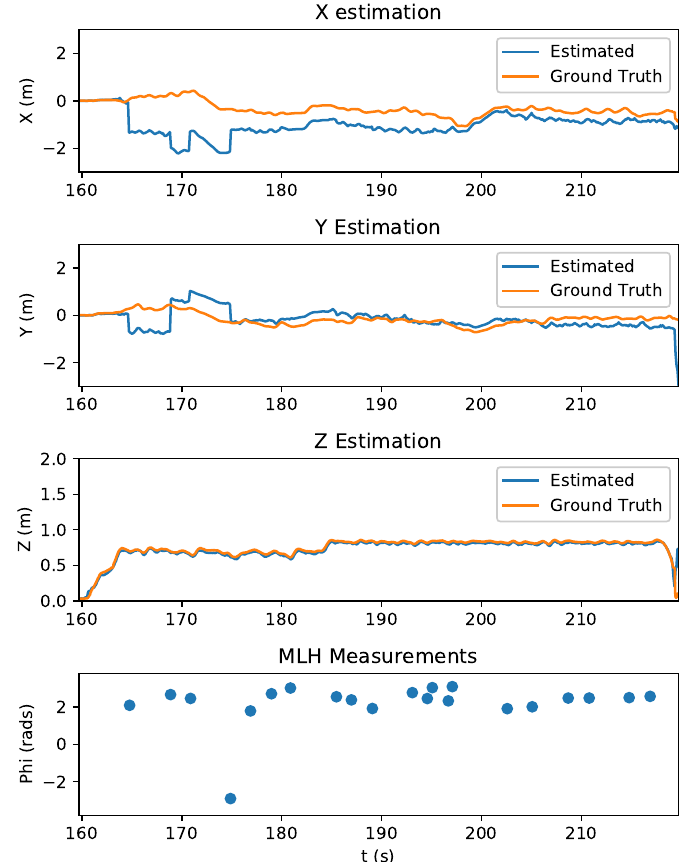
Figure 10. Results of X, Y, and Z state estimates during a quadrotor lighthouse experiment. Initial lighthouse bearing measurements were heavily weighted due to high initial state variance (see Figure 12). This is illustrated by the large discontinuities in tracking between 165 and 175 s, which correspond to lighthouse measurement updates. As the Crazyflie received more measurements from the sensor nodes, the state variance decreased (Figure 12), the measurements were less heavily weighted, and the estimator started to recover and track with less error. The bottom graph shows the received lighthouse measurements. The Z state estimation was very accurate and can be attributed to Bitcraze’s stock state estimation with optical flow deck, which includes an infrared range sensor. The bottom graph shows the quadrotor MIMSY lighthouse measurements (MLH) received by the